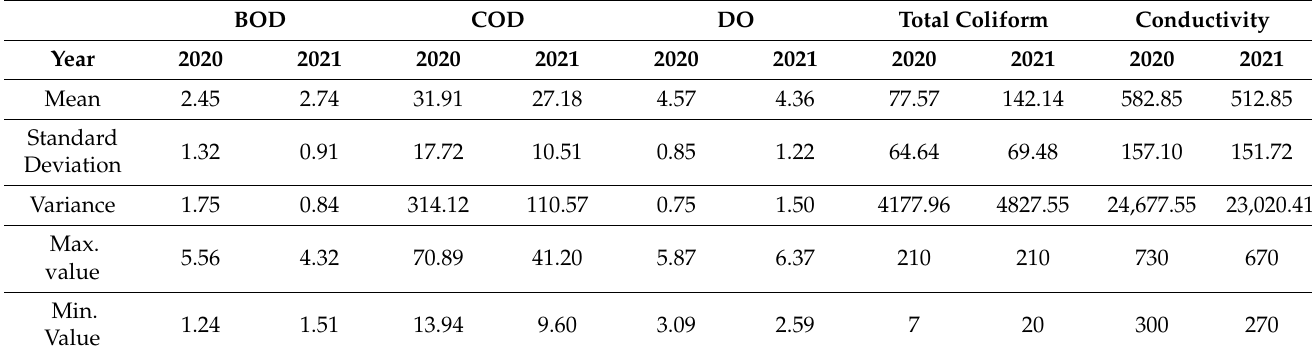
Table 2. Statistical analysis of water quality parameters of Chambal River. BOD COD DO Total Coliform